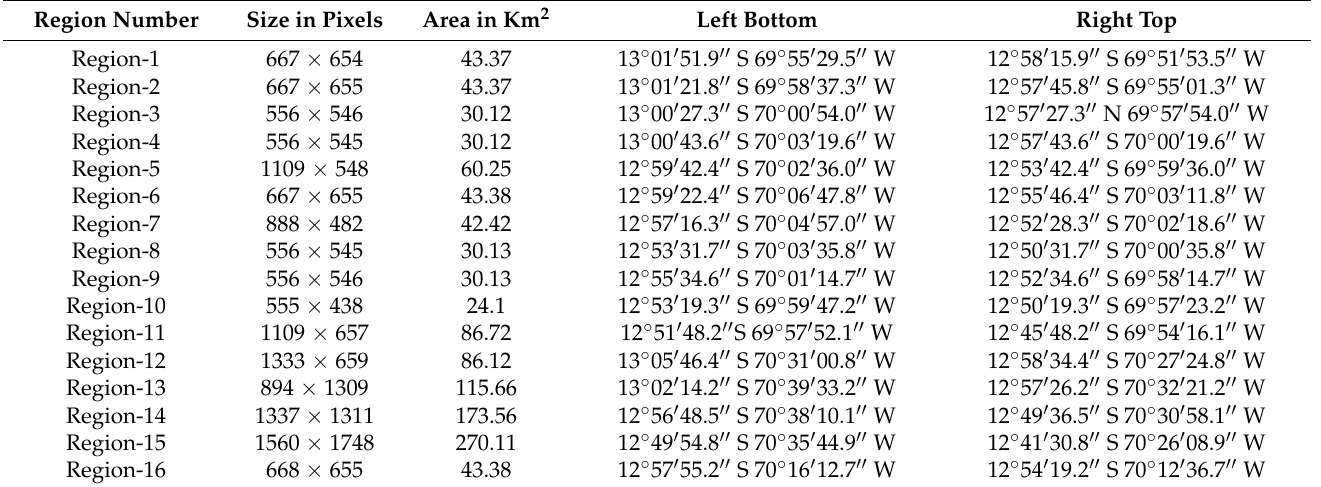
Table A1. The regions in Figure 2 with their sizes in pixel and km 2 area and their latitude and longitude of left bottom and right top.